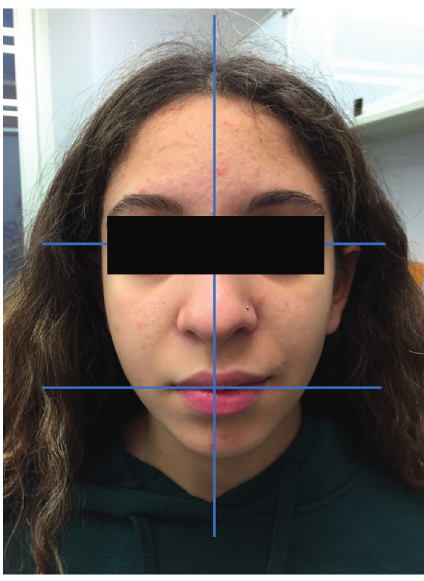
Figure 3: Two weeks treatment follow-up.